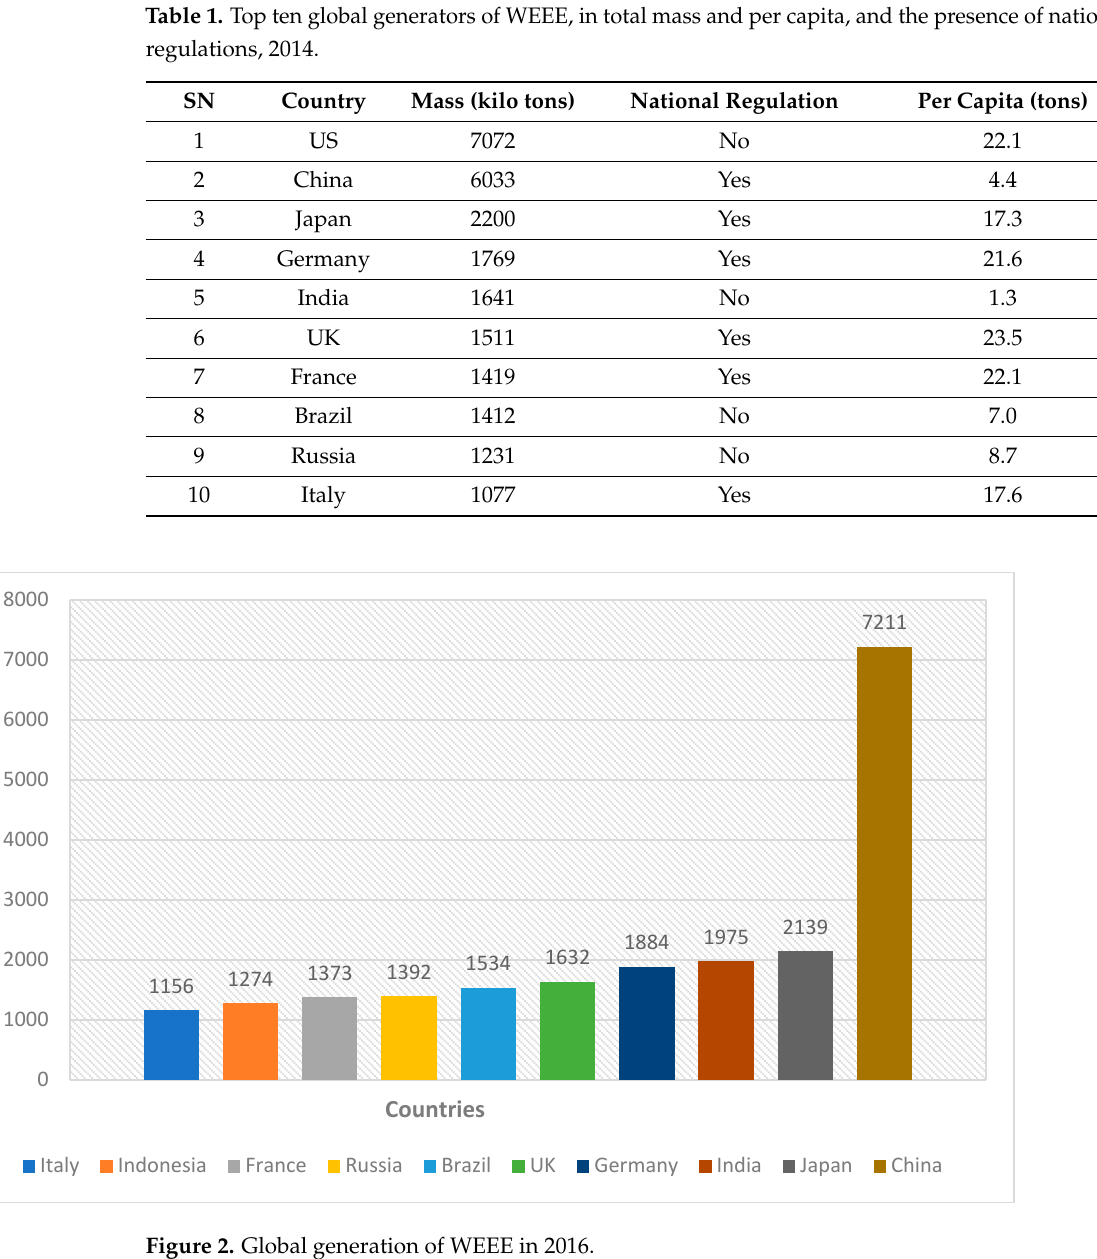
Table 2. The generators of WEEE and its collection per continent. Indicators